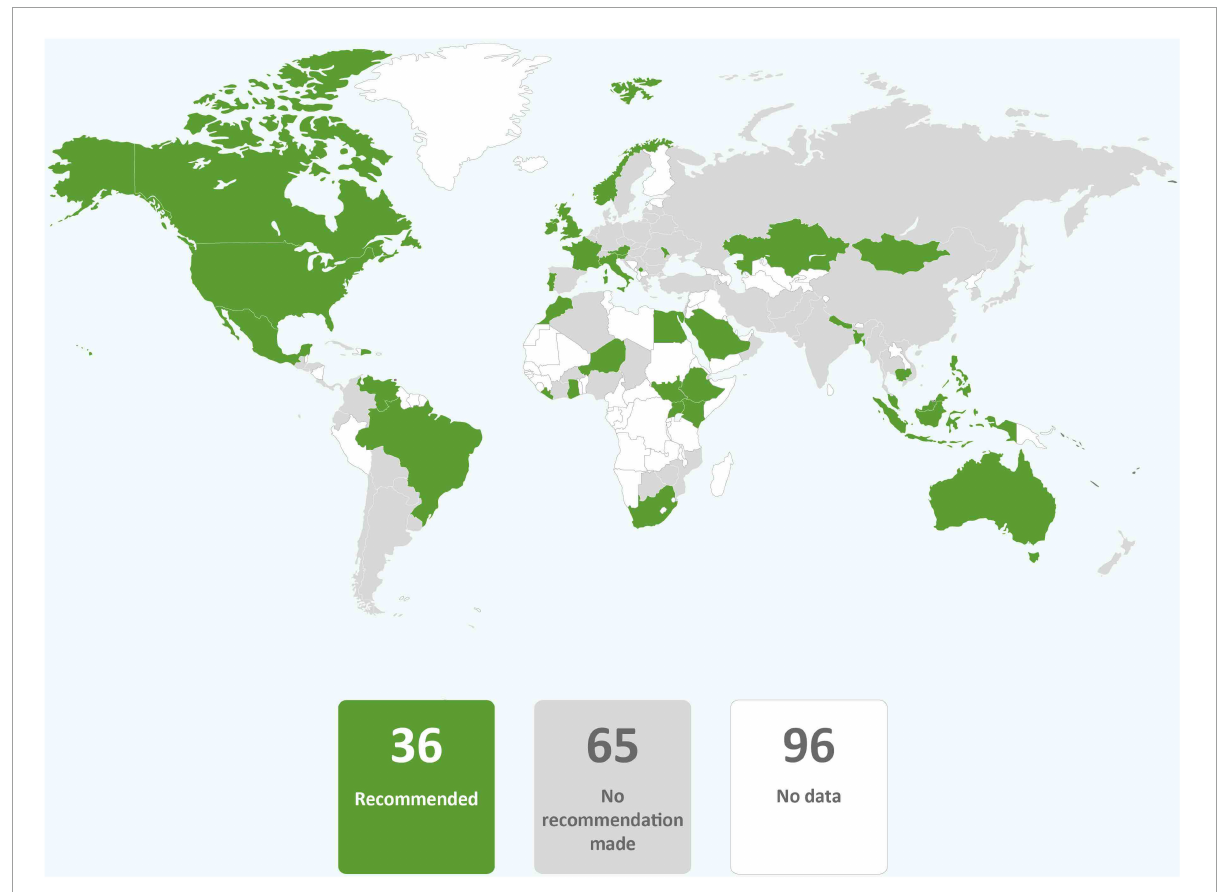
FIGURE7 Global distribution of recommendations on psychological support for mothers with COVID-19 (data from 101